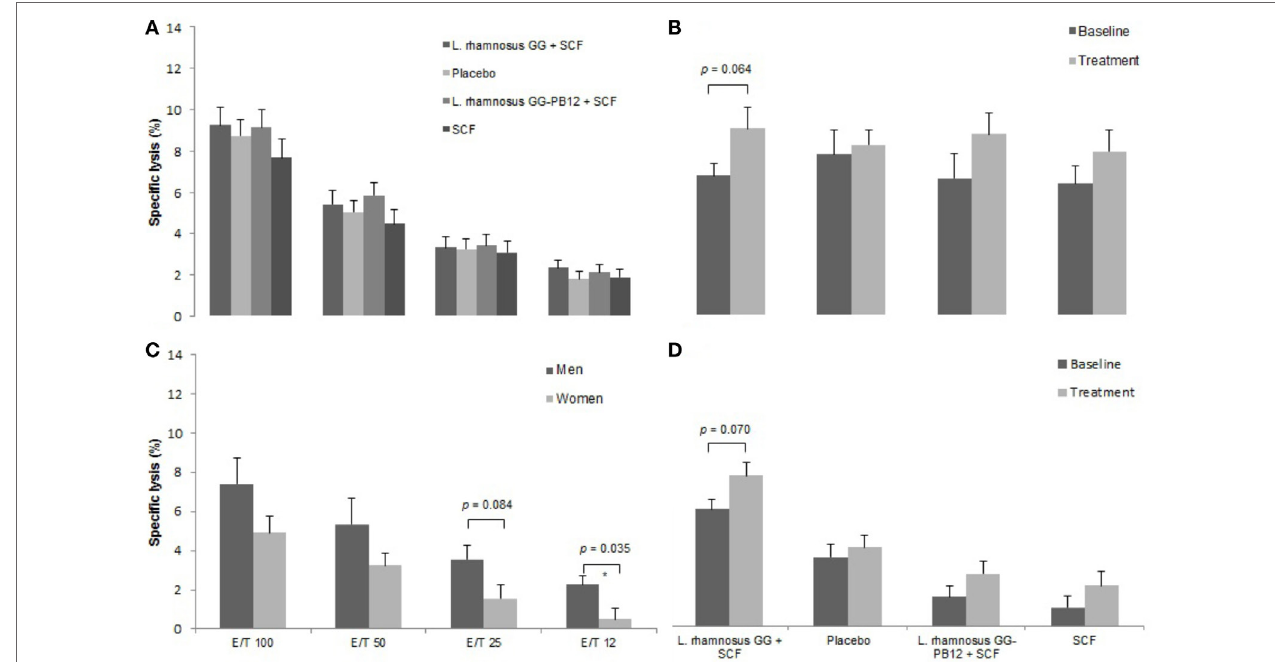
FiGUrE 4 | Natural killer cell activity in each group after the treatment. Data are mean ± SE. (a) Specific lysis after all treatments. (B) Specific lysis after LGG + Soluble Corn Fiber (SCF) intervention in females. E / T = 100/1. (C) Specific lysis at the beginning of the study in females and males. (D) Specific lysis after all treatments in the older group (70–80 years old) ( n =